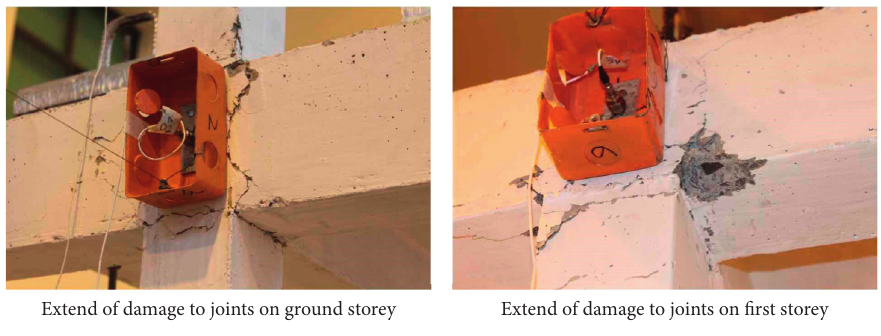
Figure 6: Observed damages in Model-3 (refer Table 3 for damage evolution; figure is reproduced from Ahmad et al.